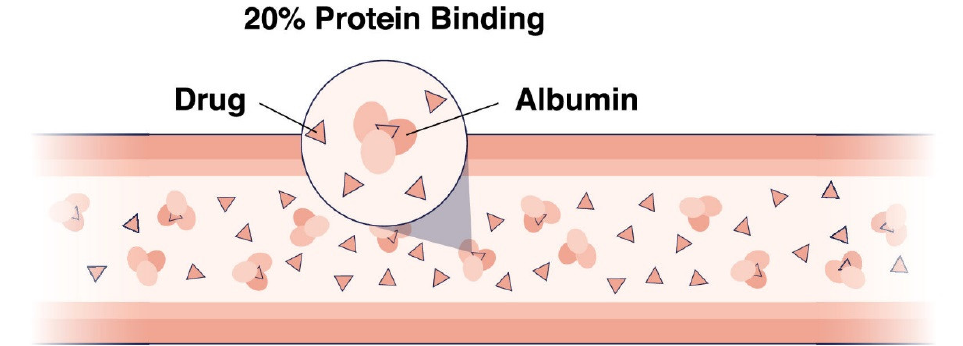
Figure 1. Interaction of drug molecules with plasma protein albumin.